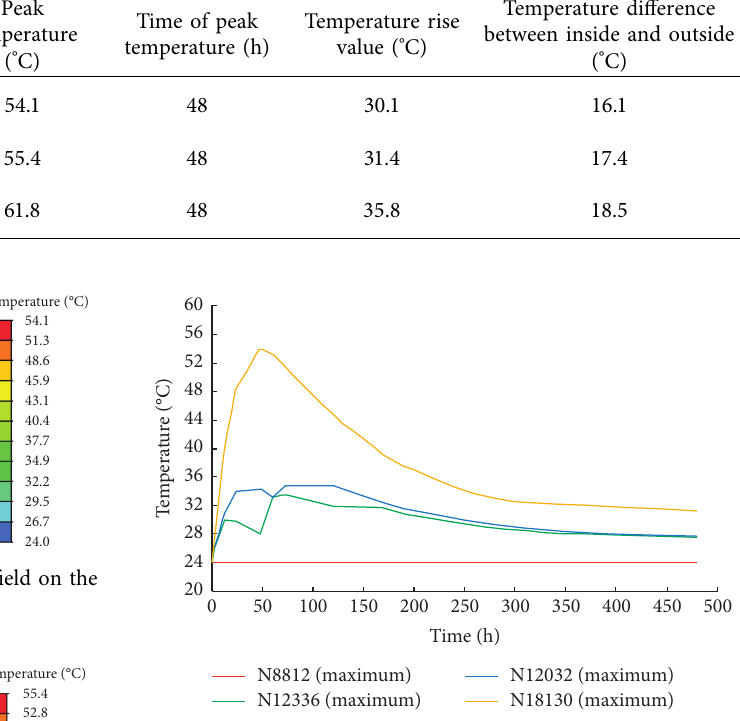
Figure 9: Time-history curve of concrete temperature of the second layer of cap.